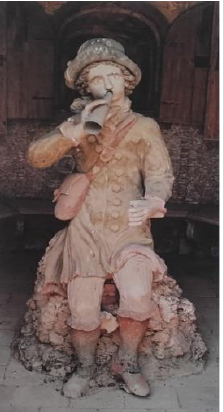
Figure 3. The polychrome figure of " Cecco Birbo " in the " “ Grotta degli automi